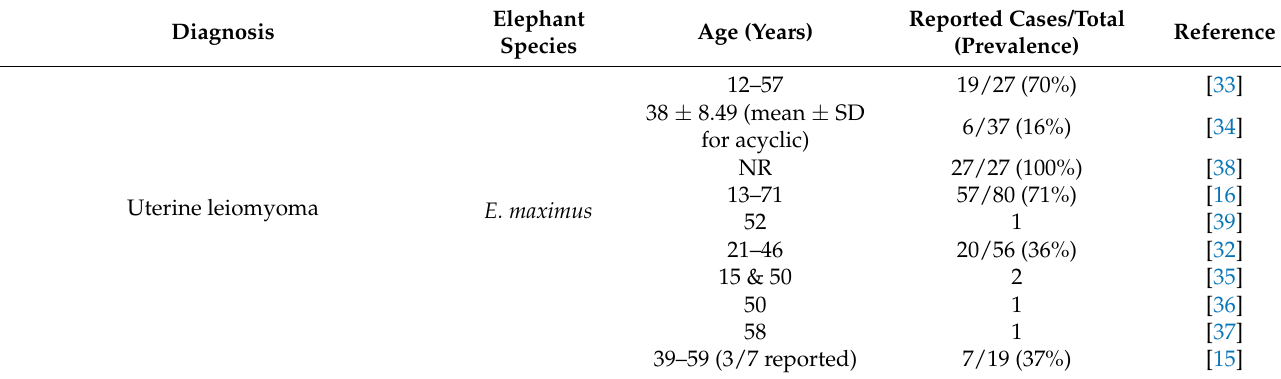
Table 1. Reproductive lesions reported in female